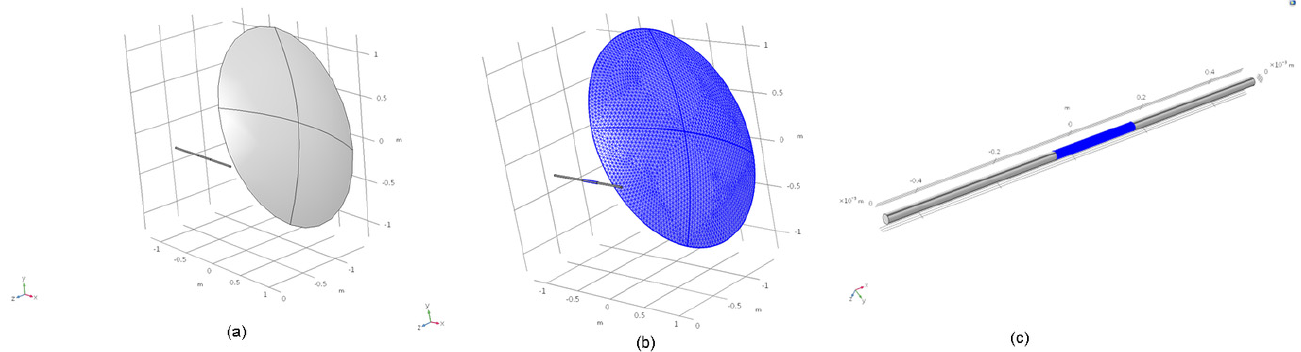
Figure 3. ( a ) Geometrical modeling of the system consisting of solar dish and horizontal cylindrical receiver. ( b ) Mesh created for the reflective surface of the parabolic mirror. ( c ) Geometrical modeling of receiver with the corresponding mesh of the focal plane in the central section.